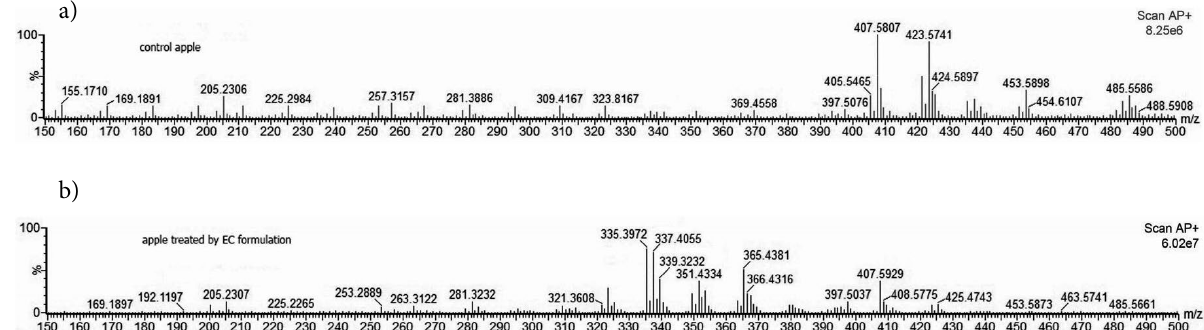
Figure 2 . ASAP-MS spectra of a control apple ( a ) and of an apple treated with 50 mg/L EC formulation and with H 2 O 2 ( b